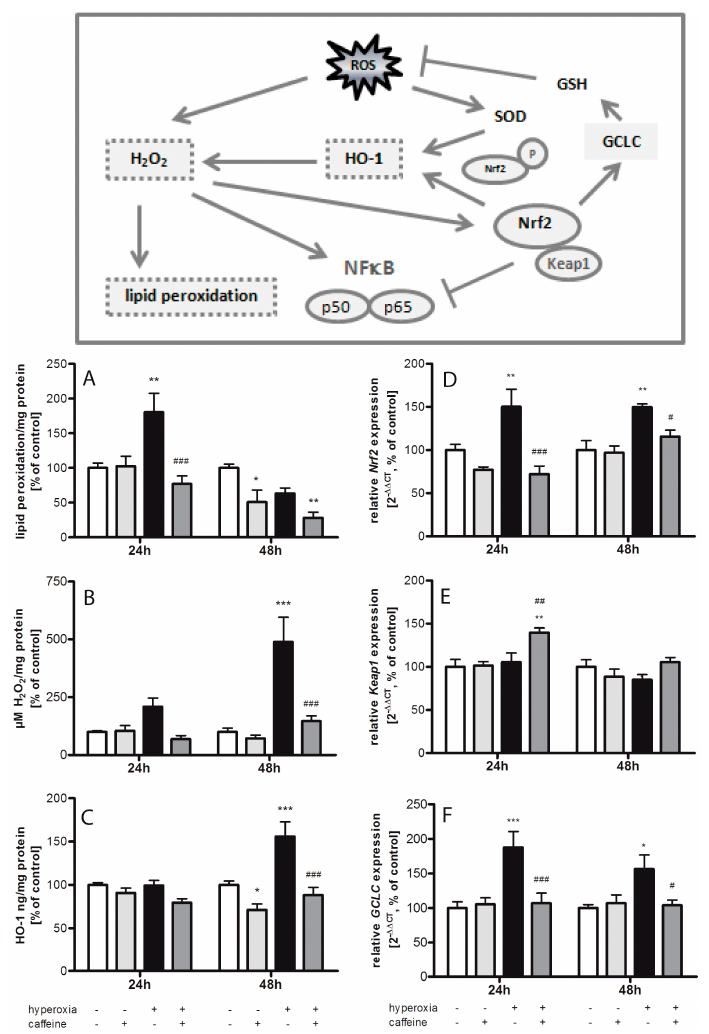
Figure 1. Caffeine reduces oxidative stress responses during exposure to hyperoxia. ( Box ) Reactive oxygen species imply hydrogen peroxide, which promotes lipid peroxidation. The antioxidant enzyme response is induced, which leads inter alia to an activation of heme oxigenase-1 (HO-1). The Nrf2-Keap1 system plays alongside the NF κ B pathway an essential role in the implementation of the antioxidant gene regulation in response to oxidative stress. The catalytic subunit of glutamate-cysteine ligase (GCLC) is upregulated by Nrf2. Quantitation of brain homogenates by ELISA of: ( A ) TBARS/lipid peroxidation; ( B ) H 2 O 2 ; and ( C ) HO-1; and mRNA expression by quantitative real-time PCR of: ( D ) Nrf2 ; ( E ) Keap1 ; and ( F ) GCLC . Groups are shown as normoxia ( white bars ), hyperoxia ( black bars ), with and without caffeine ( dark grey and light grey bars , respectively) as mean ± SEM, n = 4–5 per group per time point. The 100% value is: ( A ) 1.268 and 1.959 µM/mg protein; ( B ) 0.887 and 2.946 µM/mg protein; ( C ) 3.604 and 2.891 ng/mg protein; ( D ) 1.008 and 1.029 C T ; ( E ) 1.014 and 1.029 C T ; and ( F ) 1.016 and 1.015 C T for 24 and 48 h groups, respectively. Data were analyzed by two-way ANOVA with Bonferroni post hoc test, with * p < 0.05, ** p < 0.01, and *** p < 0.001 versus control (atmospheric air), and # p < 0.05, ## p < 0.01, and ### p < 0.001 versus hyperoxia (80% oxygen without caffeine). Heme oxigenase-1 (HO-1) protein levels were markedly increased in brain tissue after 48 h of hyperoxic stimulation (156% ± 16.8%; p < 0.001) compared with brain tissue from rats under normoxia (Figure 1C). Caffeine reduced the protein level significantly after 48 h hyperoxia (88% ± 8.9%; p < 0.001). HO-1 is not increased after 24 h hyperoxia. However, caffeine treatment reduced HO-1 levels after 48 h in control litters kept in room air (71% ± 15.6%; p <